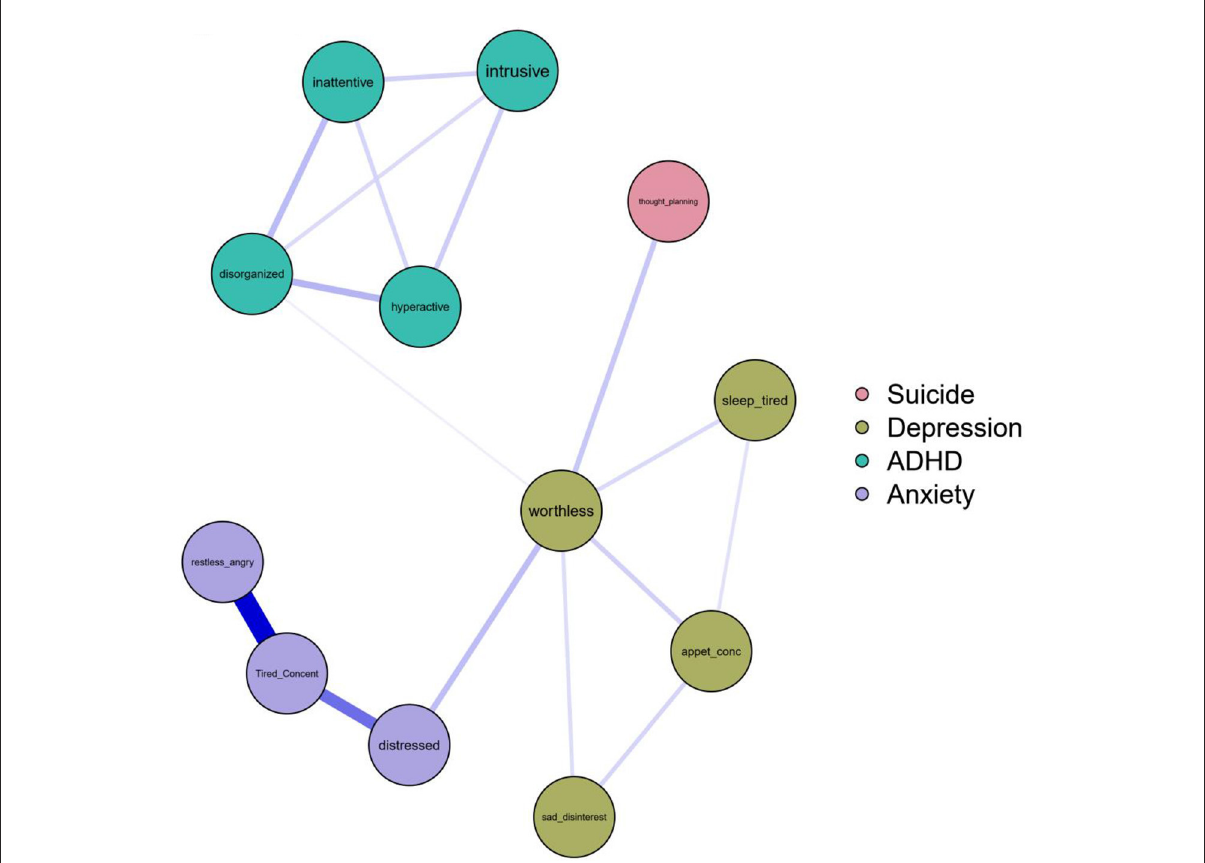
FIGURE5 After creating the binary categories, the regulated Ising network model was estimated with one suicidality (thought and planning), three anxiety (distress, tiredness and concentration problems, restless and angry), four depression (sad and disinterested, appetite and concentration problems, sleepy and tired, worthless), and four ADHD (intrusive, inattentive, disorganized, hyperactive)